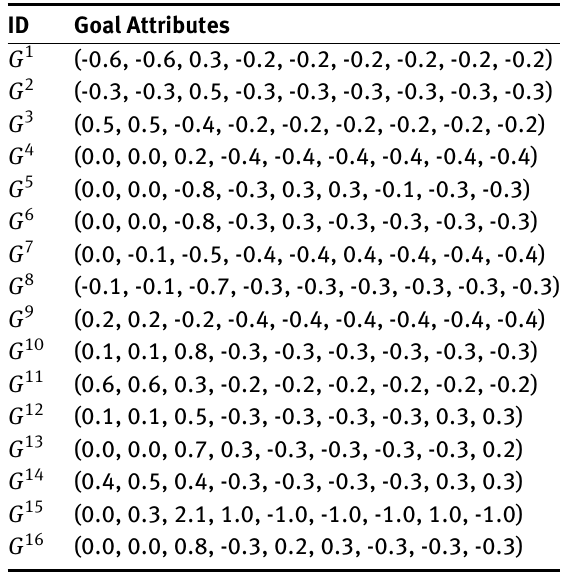
Table 6: Maintenance goal prototypes generated in the first run of experiment 3 with ρ M = 0.6. Weights are rounded to 1 decimal place.